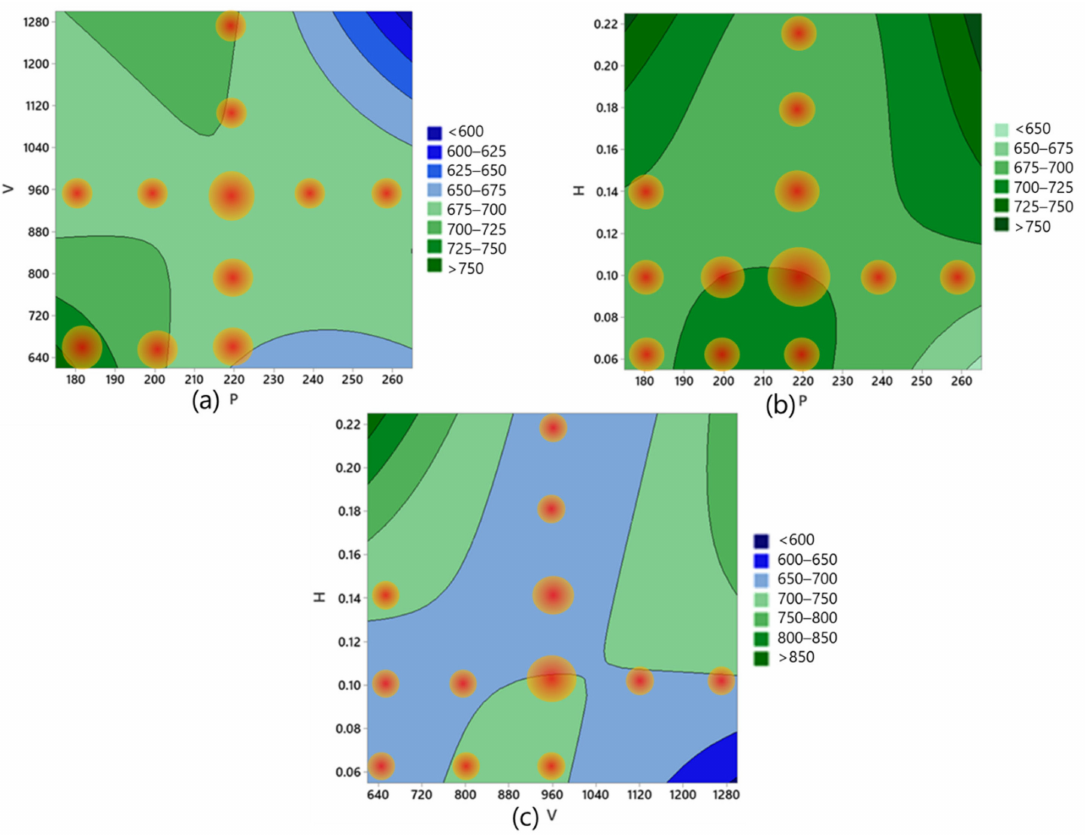
Figure 6. ( a ) Self-growing populated data volume in the P–V–TS model, ( b ) self-growing populated data volume in the P–H–TS model, and ( c ) self-growing populated data volume in the V–H–TS model. After obtaining the self-populated data, 80% of the data are used for training and 20% for testing in the following analysis. The accuracy and validation of the proposed machine-learning network will be presented in Section 5.